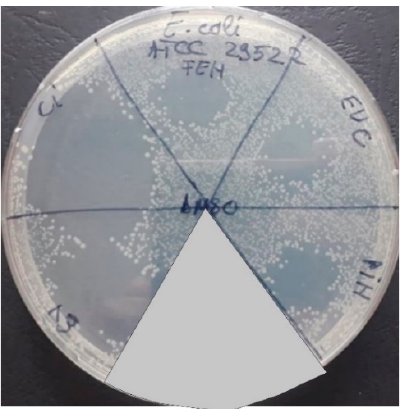
Figure 5. The aspect of the inhibition zones expressed by the Gram-negative strains Escherichia coli ATCC 25922 in the presence of tested EO at 1/10 dilution in DMSO; FEN (fennel EO); SV (sage EO); EUC (eucalyptus EO); CI (thyme EO); PIN (pine EO).